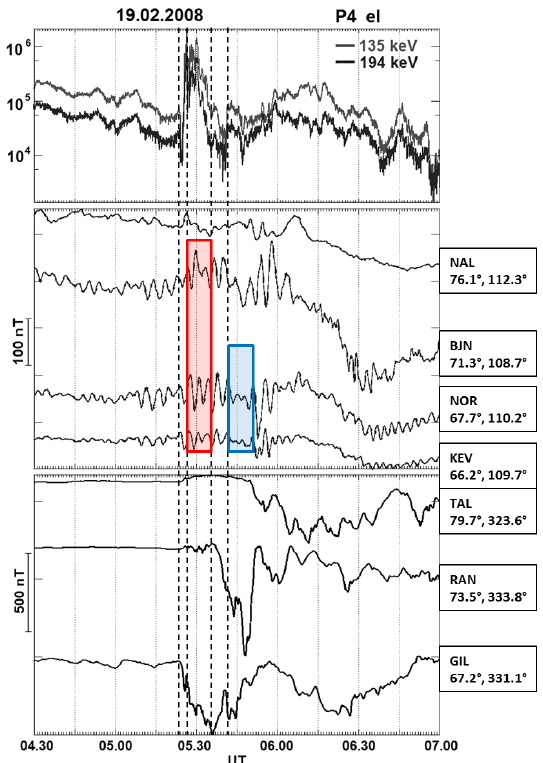
Figure 3. Ground-based and satellite observations during the sub- storm event on 19 February 2008. From top to bottom, electron fluxes as measured by the THEMIS Probe 5, geomagnetic pulsa- tions at Fennoscandian stations BJN, NOR, KEV, magnetometer data from Greenland (NAQ) and eastern Canada (NAN), and mag- netometer data from the THEMIS ground-based stations. The times of Pc5 intensifications and weakenings are marked with red and blue shadings (adapted from Kauristie et al.,